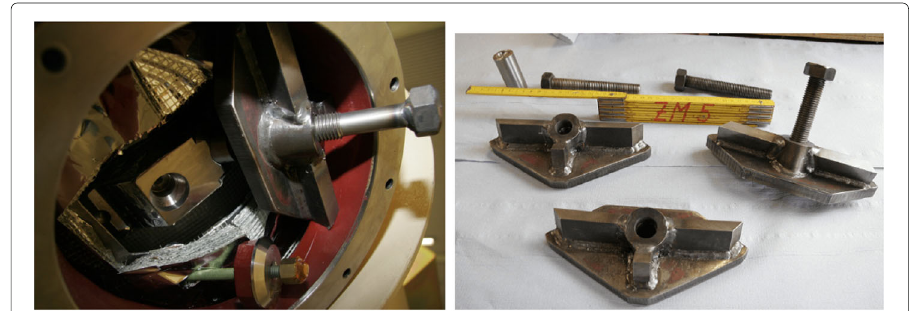
Fig. 11 Pressure screw mounted into the vacuum vessel in the middle of the cryostat for the deformation of the cold mass (left), Pressure screws (right)